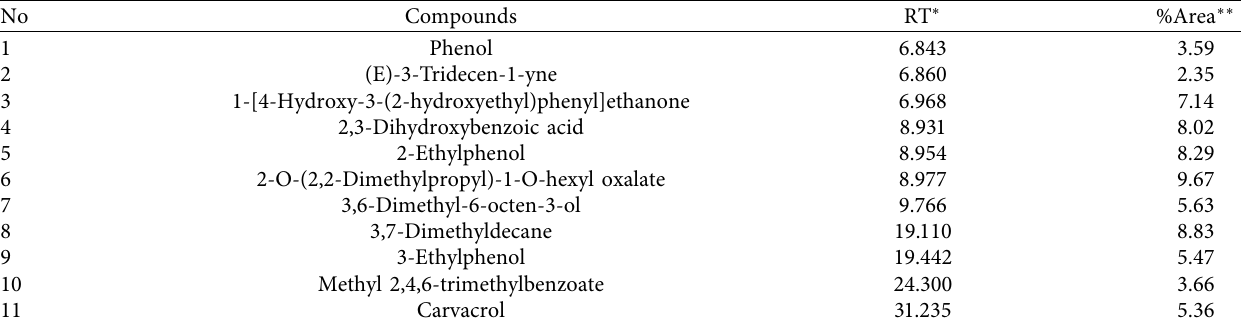
Table 3: The obtained compounds in straw-derived lignin depolymerization in conditions of 50% ethanol, 275 ° C, 30 min, 75:1 (mL ethanol: 1g